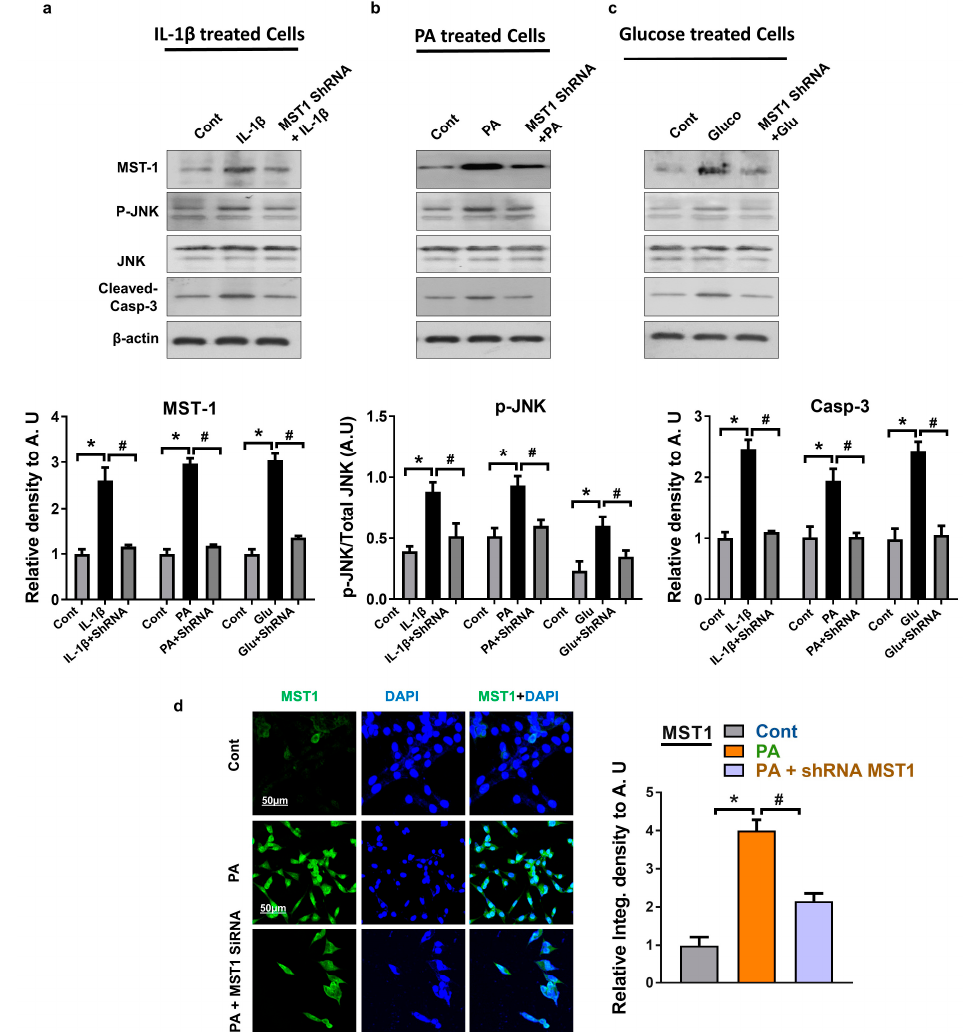
Figure 4. E ff ect of shRNA MST1 on JNK / Casp3 in HT22 cells: ( a – c ) Shown are the Western blot results Figure 4. Effect of shRNA MST1 on JNK/Casp3 in HT22 cells: ( a – c ) Shown are the Western blot results of MST1, p-JNK, and Cleaved-Casp-3 in IL-1 β , palmitic acid, and glucose treated cells HT22